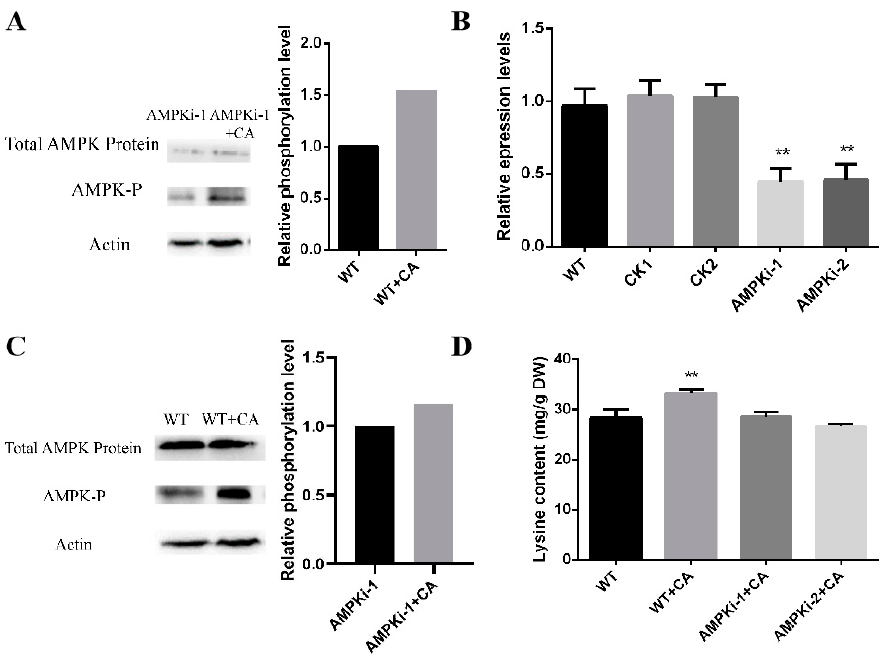
Figure 6. Changes in lysine in AMPK-silencing transformant induced by citric acid. ( A ) AMPK total protein indicates the detection of AMPK total protein level under optimal induction of WT and citric acid; AMPK-P indicates the detection of AMPK phosphorylation level under the optimal induction of WT and citric acid. The level of relative phosphorylation induced by optimal citric acid was meas- ured using Western blot band brightness, and the phosphorylation level of AMPK in WT was set to 1. ( B ) The figure shows the quantitative transformation of silencing transformants by fluorescence quantitative PCR. (**, p < 0.01). ( C ) The phosphorylation level of AMPK-silenced transformants is shown. AMPK total protein indicates detection of silenced transformant uninduced and citric acid optimal induction of AMPK total protein level. AMPK-P indicates detection of silent transformant uninduced and optimal citric acid induction lower AMPK phosphorylation level. The relative phos- phorylation level of the silenced strain under optimal citric acid induction is shown. The brightness of the Western blot band was determined, and the phosphorylation level of AMPK in the silenced strain was set to 1. ( D ) The lysine content of F. filiformis AMPK-silencing strain under citrate unin- duced and optimal induction. (**, p < 0.01).